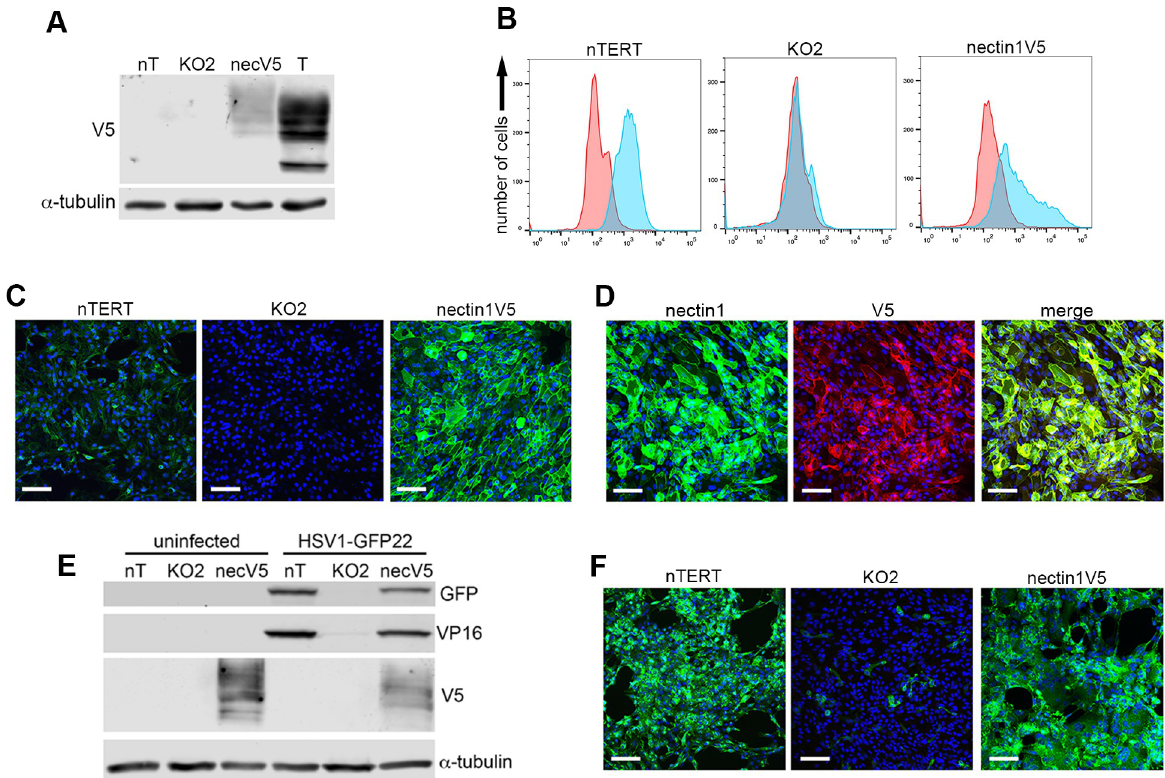
Fig 3. HSV1 infection is rescued in nectin1 knockout cells stably expressing nectin1V5. (A) KO2 cells that had been selected for stable nectin1V5 expression (necV5) were analysed by SDS-PAGE and Western blotting with antibody for V5 and α -tubulin alongside nTERT (nT) and KO2 cells. T, nTERT cells transiently transfected with plasmid expressing nectin1V5. (B) Flow cytometry of non-permeabilised nTERT, KO and nectinV5 cells was carried out using nectin1 antibody (blue) compared to secondary only (red) to measure nectin1V5 at the cell surface. (C) nTERT, KO2 and nectin-V5 cells were grown on coverslips, fixed without permeabilisation and stained with nectin1 antibody (green). (D) Nectin1V5 cells grown on coverslips were fixed, permeabilised and stained with antibodies to nectin1 (green) and V5 (red). Scale bar = 100 μ m. (E) nTERT, KO and nectin1V5 cells were infected with HSV1 expressing GFP22 MOI 5 and analysed by SDS-PAGE and Western blotting after 12 h for GFP, VP16, V5 and α -tubulin. (F) As for (E) but cells were grown on coverslips, and infected cells were fixed at 8 h nuclei stained with DAPI (blue) and cells imaged for GFP fluorescence (green). Scale bar = 100 μ